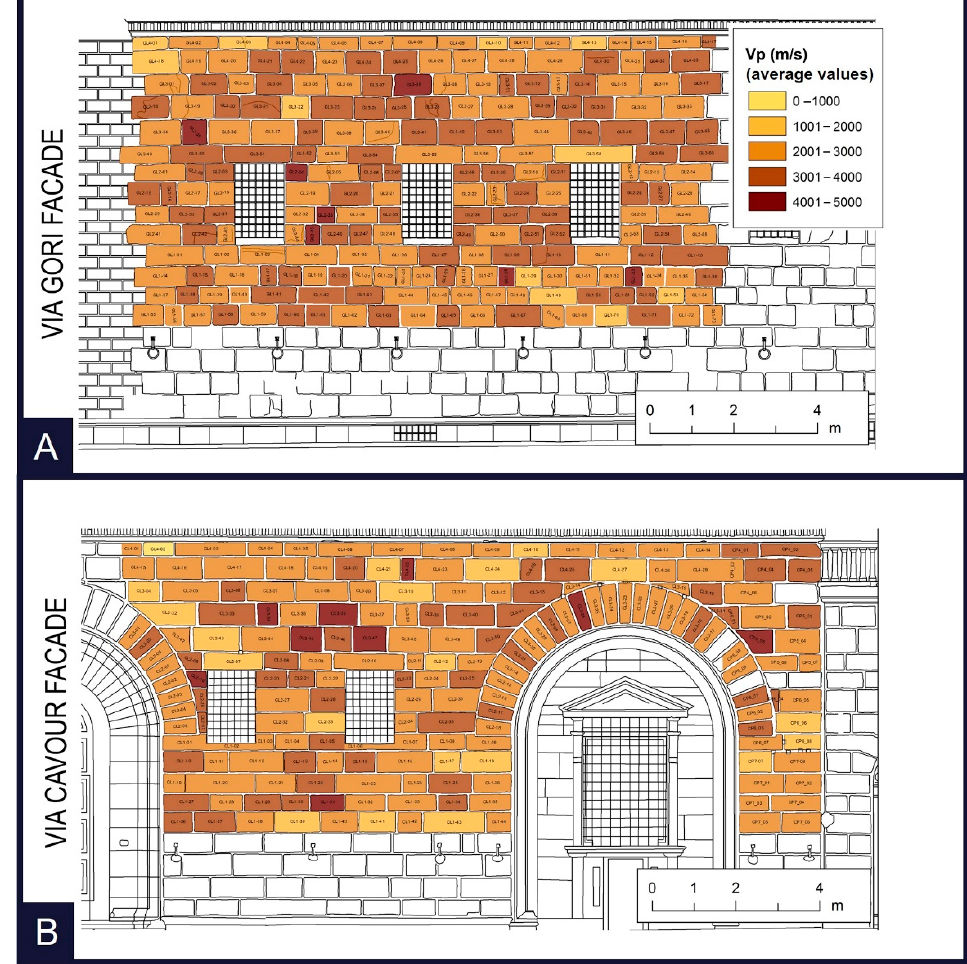
Figure 9. Average Vp value maps processed through GIS software, related to blocks on ( A ) Via Gori and ( B ) Via Cavour.